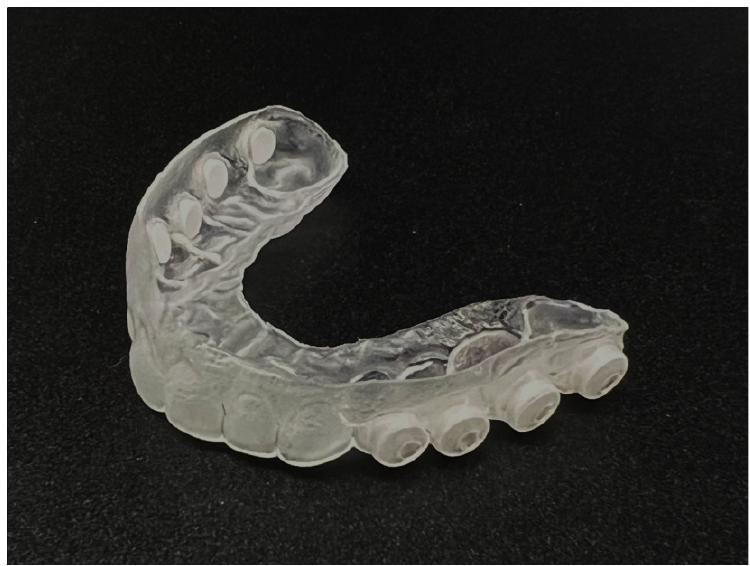
Figure 1. Photograph of the intra-oral retainer fitted with hydroxyapatite